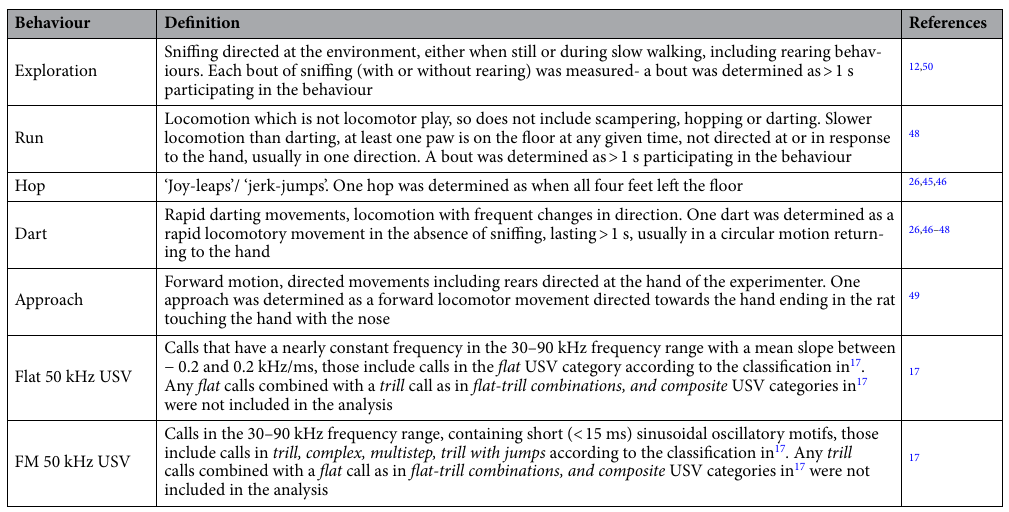
Table 1. Ethogram used to carry out the behavioural analysis of the rats response to tickling. The following table defines the list of rat behaviours quantified with their description and reference to previously published